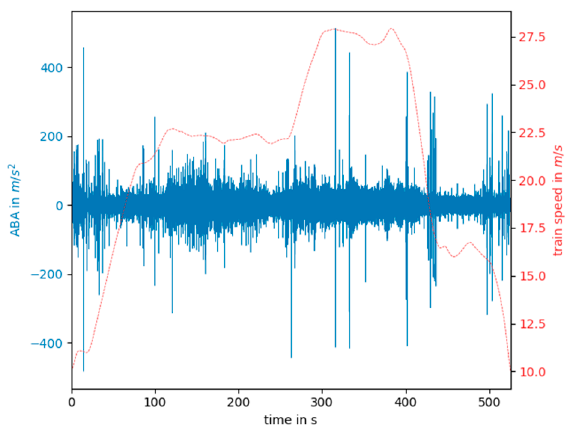
Figure 5. Axle-box accelerations (ABA) data (solid blue line) and speed data (dashed red line) in the time domain.